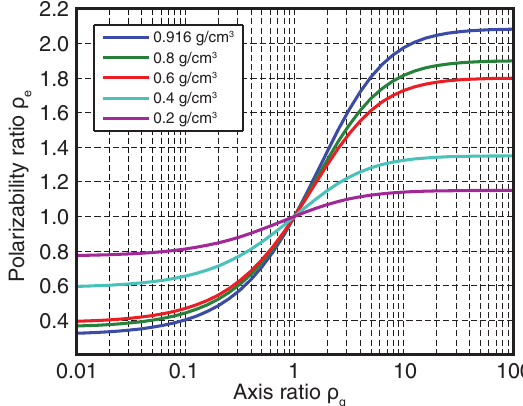
Figure 11. Probability density function of (cid:50) for different values of R . Adopted from Kanareykin et al. (1966).